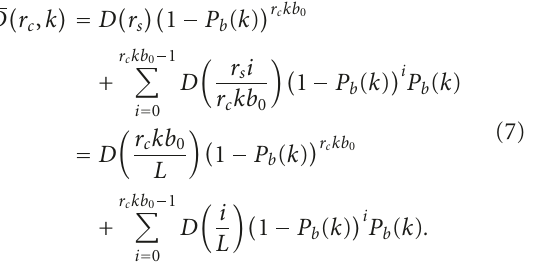
Figure 2: PSNR versus E s /N 0 performance of using an uncoded M - PSK system (with M = 2 k for k = 1,2,3,4) for transmitting the 512 Lena image using b 0 = 65,536 sym- SPIHT compressed 512 (cid:0) bols. The source coding rate is 0 . 25, 0 . 5, 0 . 75, and 1bpp, respec- tively, for k = 1,2,3, and